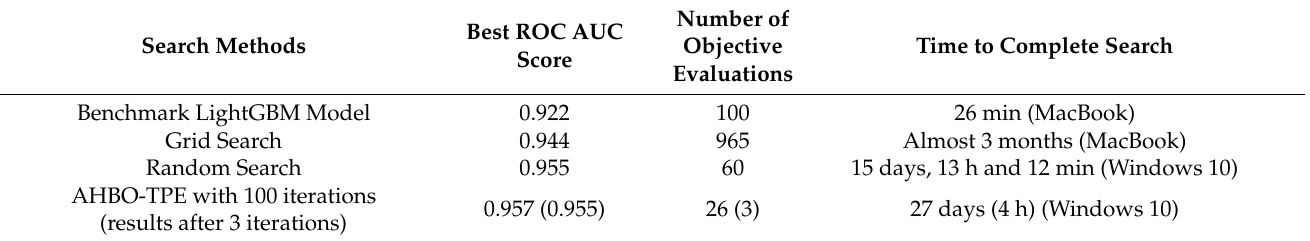
Table 2. Score Comparison of HPO Methods (Ember Dataset).